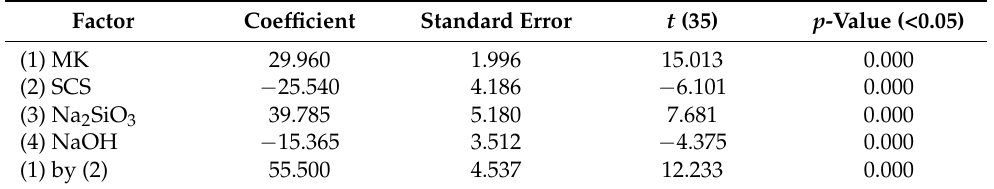
Table 4. Multiple regression analysis for compressive strength and raw materials of the SCSGPs (r 2 =